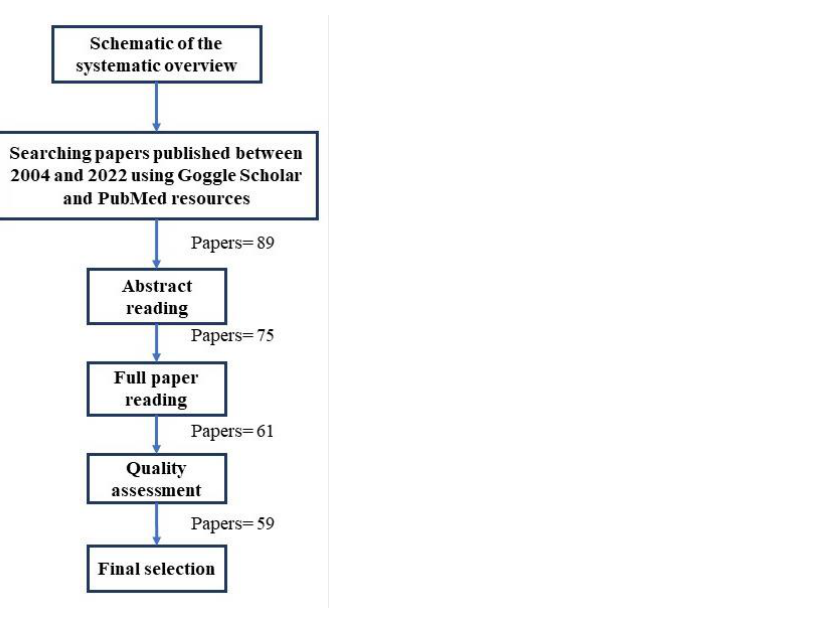
Figure 1. An illustration in schematic form of the overall systematic overview.